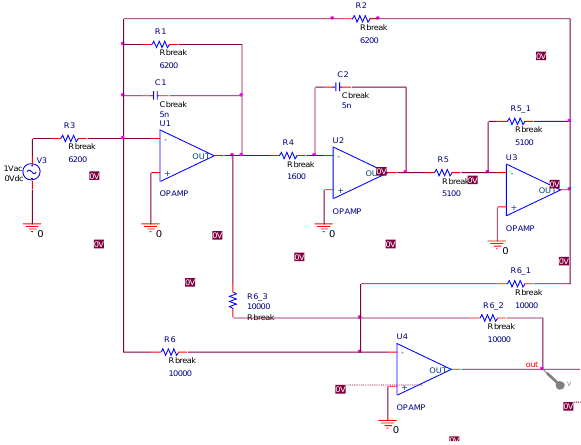
Figure 8. Sketch map of biquad quad-op amp low-pass filter.